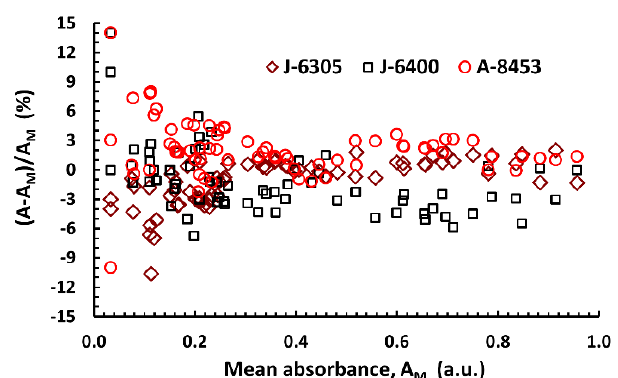
Figure 4. Graphical analysis of all corresponding absorbance measurements (at 320, 400, and 500 nm) taken using different spectrophotometers (see the Materials and Methods section for details), showing the random scattering of points around the mean value. Lack of ordering suggests that instrumental correction factors in turbidimetric measurements are either negligible for small particle sizes or extremely similar, despite different device specifications. However, it is apparent that measurements at attenuation values higher than 0.2 a.u. should always be preferred when the turbidity of a sample (and not “true” absorbance/attenuation) is being evaluated.